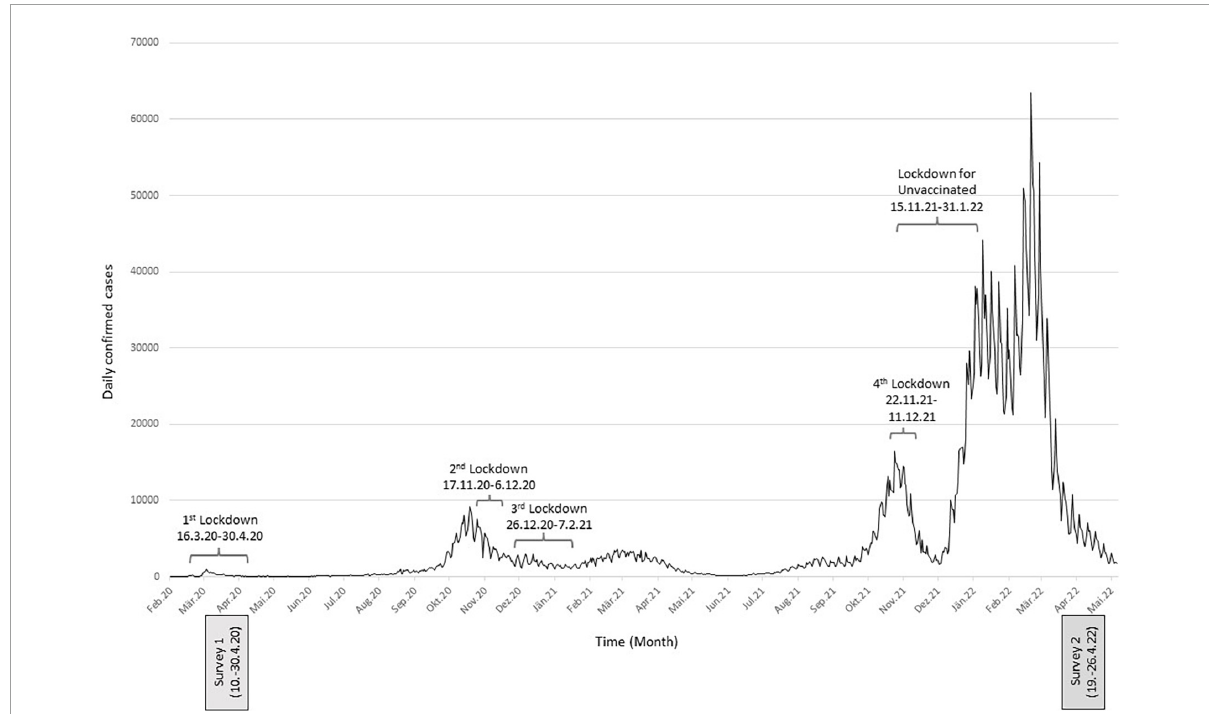
FIGURE1 Daily confirmed COVID-19 cases in Austria, lockdown measures in place, and sampling